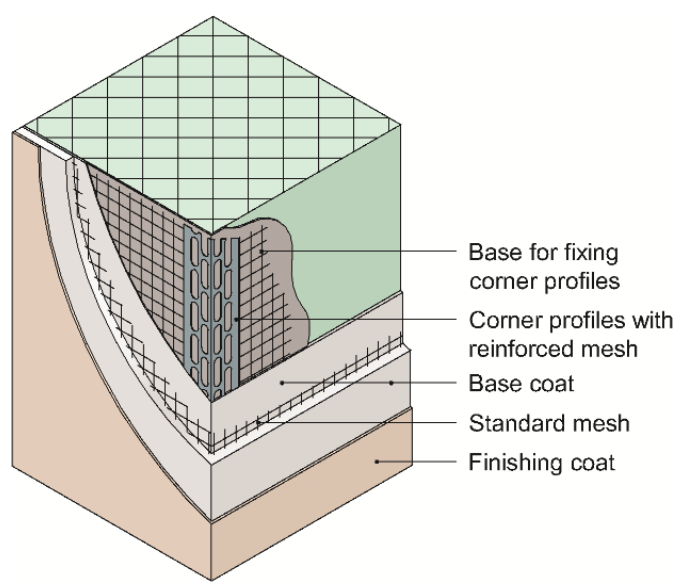
Figure 10. Example showing how effective corner reinforcement can be achieved.